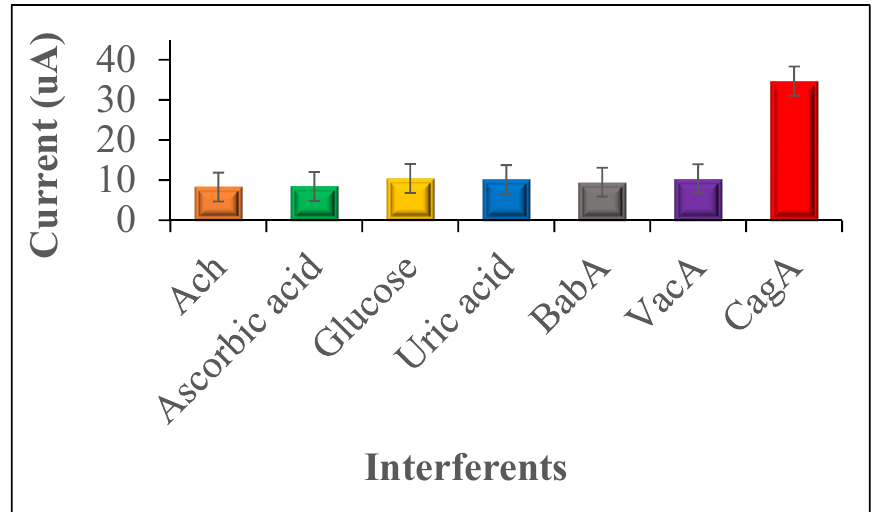
Figure 11. Plot of interferent studies of MIP-CagA/Au/rGO@SPE with 0.05 ng/mL CagA antigens.